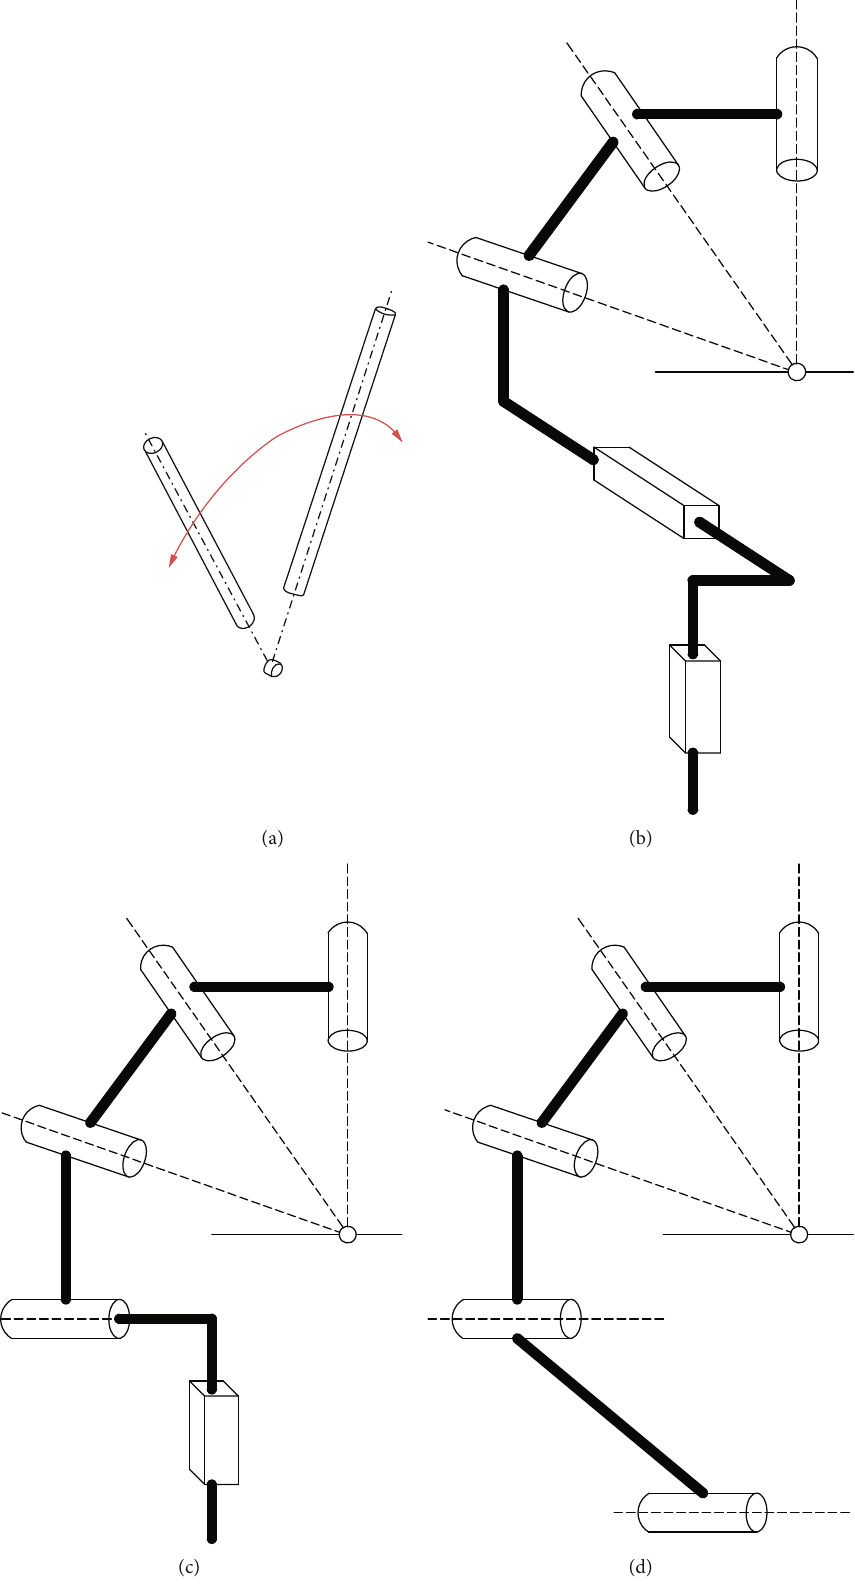
Figure 17: Modular units of adaptive levelling